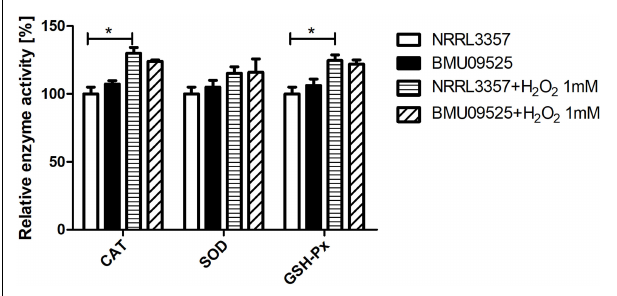
FIGURE 6 | Determination of the enzyme activities of SOD, CAT and GSH-Px. A total of 1 × 10 6 CFU A. flavus conidia were preincubated in Aspergillus minimal medium for 18 h at 37 ◦ C and 200 rpm before H 2 O 2 (1 mM) was added for 2 h. Then the hyphae were harvested and enzyme activities were determined according to the manufacturer’s instructions. The relative enzyme activities (%) were calculated relative to those of A. flavus NRRL3357 under basal conditions. CAT, catalase; SOD, superoxide dismutase; GHS-Px, glutathione